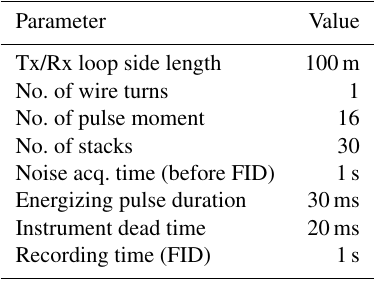
Table 3. The MRS measurement configuration used in this